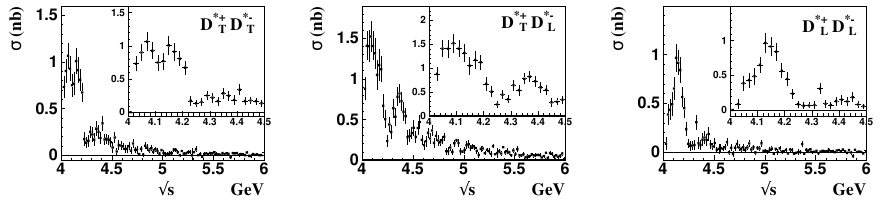
Figure 4. The components of the e + e − D ∗ D ∗ γ ISR cross section corresponding to the di ff erent D ∗± ’s → helicities. The insets show the zoomed spectrum near the threshold with a half-size bin